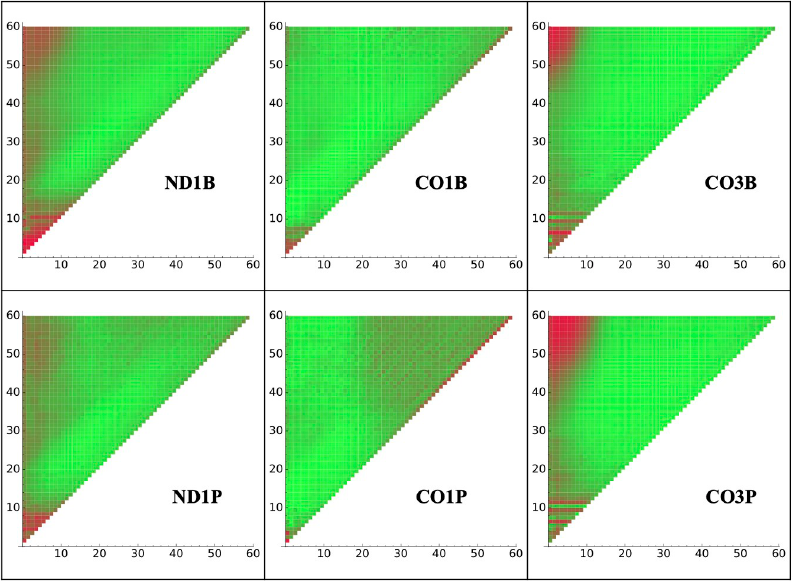
Fig 1. Tail composition by length. U/A composition of tails at each nucleotide position indicated on the x axis (Position 1 is the first non-encoded nucleotide attached to the mRNA’s 3’ end) for the population of tails of exactly each length specified on the y axis. Red and green indicate 100 percent U and 100 percent A,